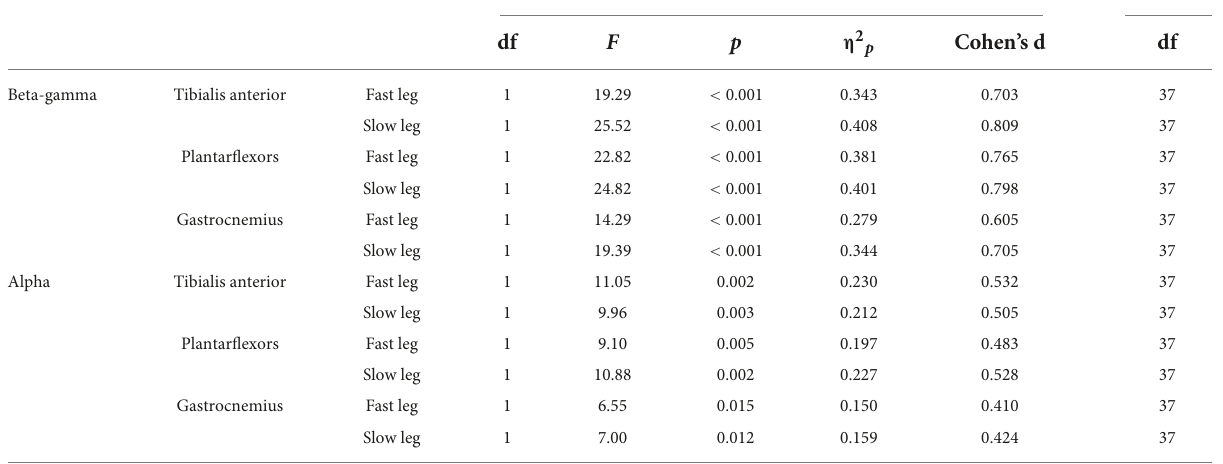
TABLE 5 Main effect of age groups for